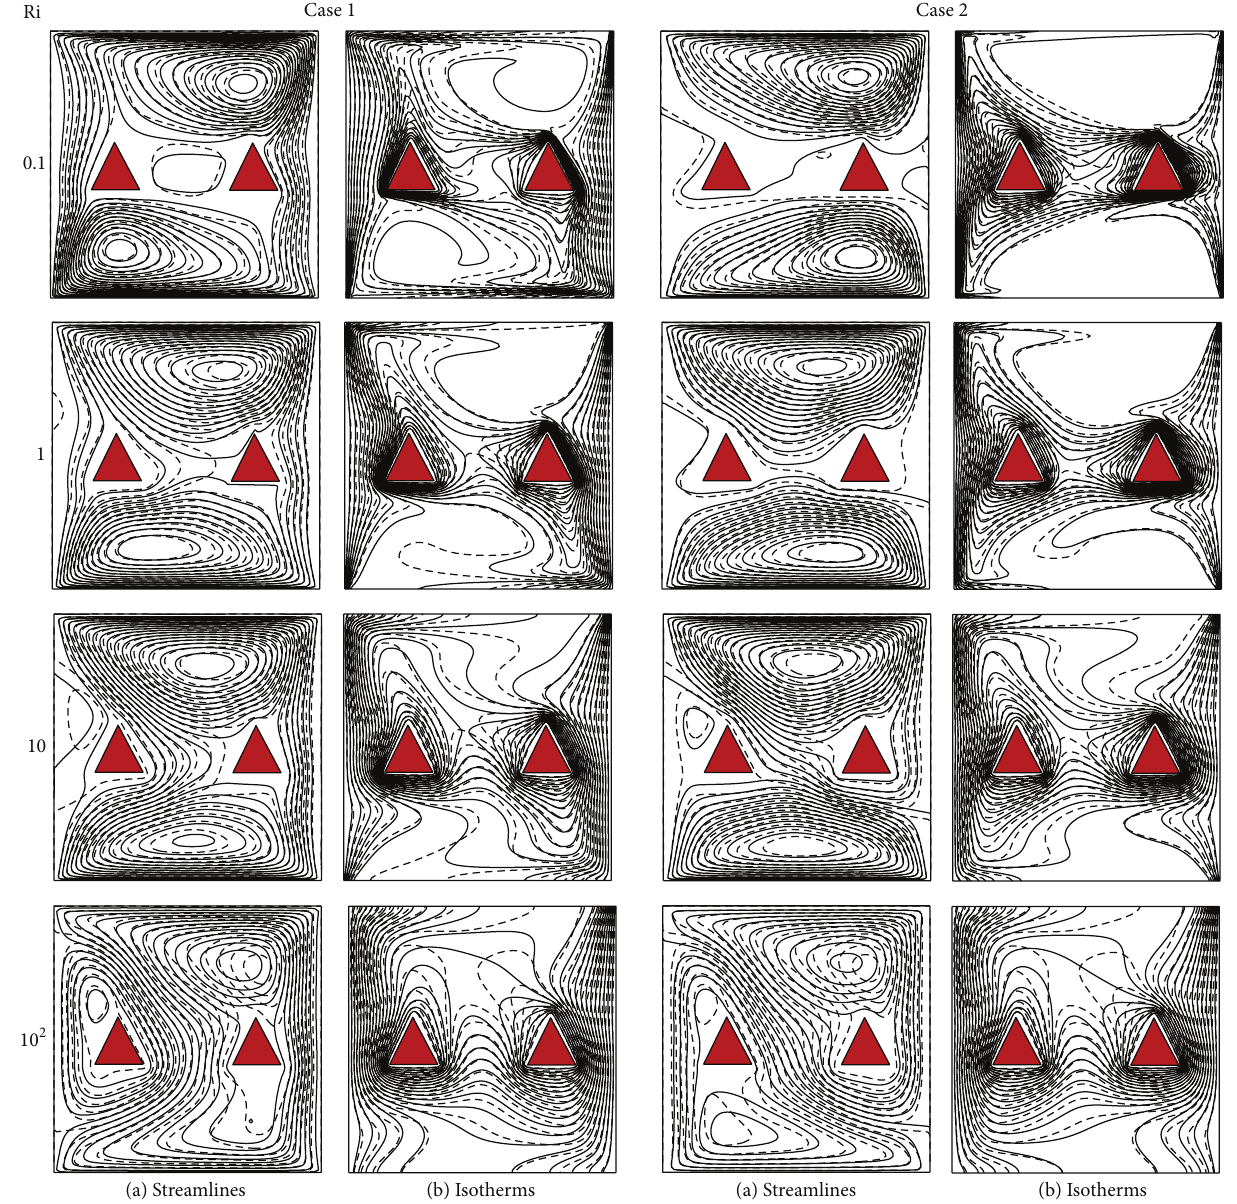
Figure 3: (a) Streamlines and (b) isotherms inside the cavity with a pair of triangular heat sources (𝑊 = 𝑤/𝐻 = 0.2) filled with Cu-water pure fluid (dashed line) and Cu-water nanofluid (solid line) with 𝜑 = 5 % and at different Ris for Cases 1 and 2. Gr = 10 4